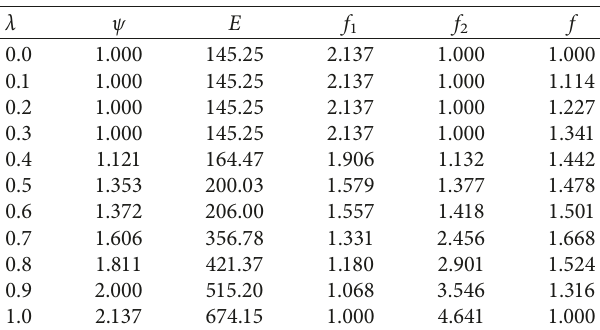
Table 2: The ψ , E , and corresponding function values for Test